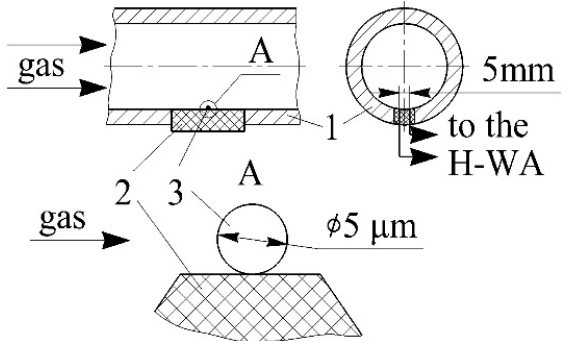
Figure 15. Detailed diagram of the hot-wire anemometer sensor in the pipe: 1—pipeline; 2—fluoro- plastic substrate; 3—sensitive element of the sensor.